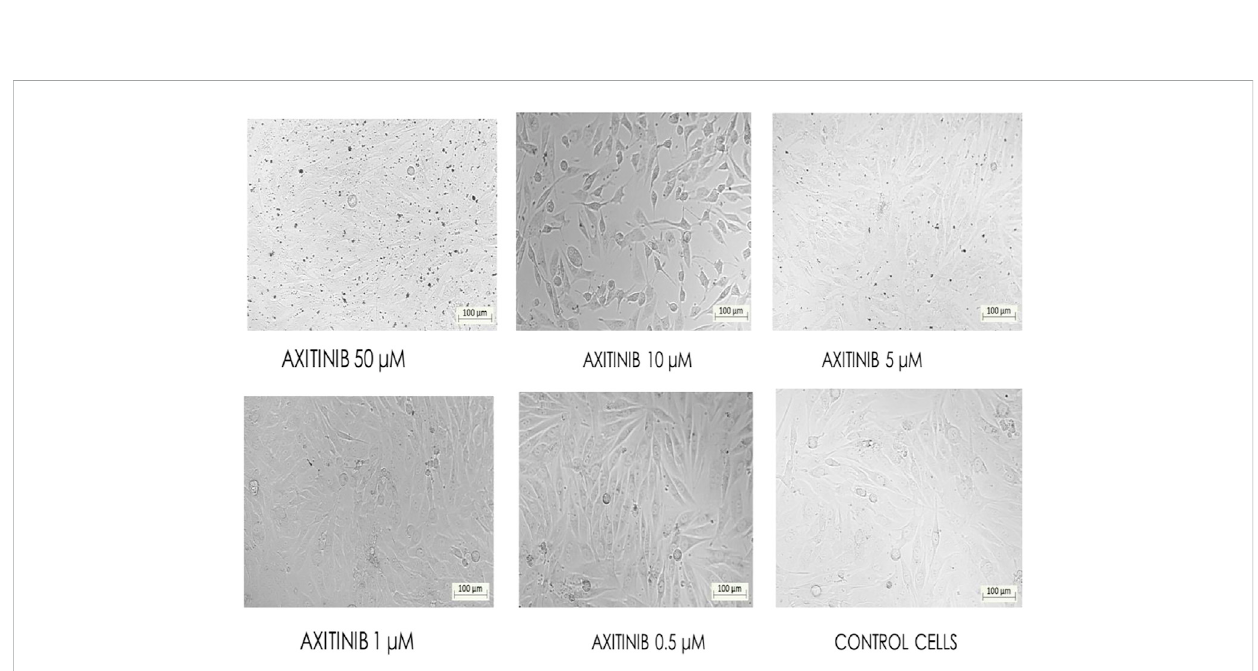
Bio-imaging of control and different concentrations of axitinib-treated MG-63 cells as con fi rmed by the MTT assay (Magni fi cation -